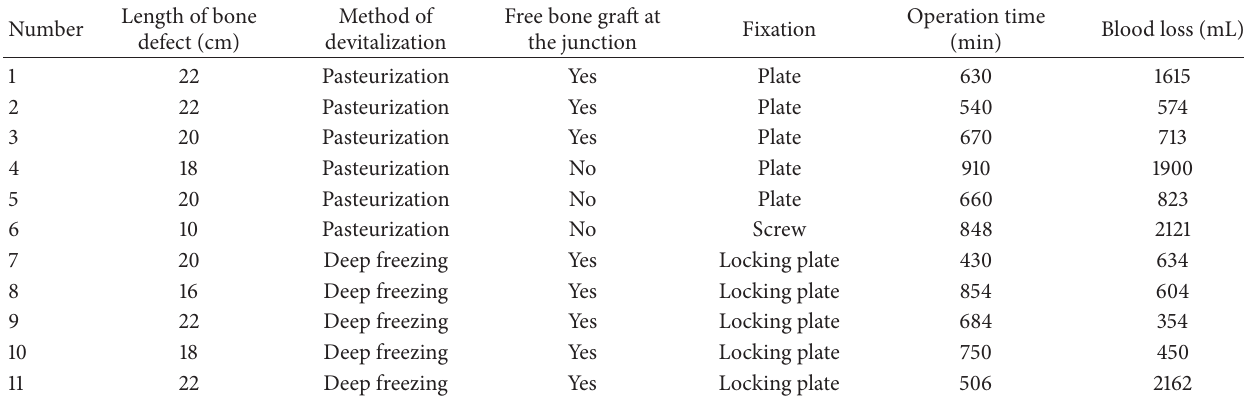
Table 2: Surgical details of the